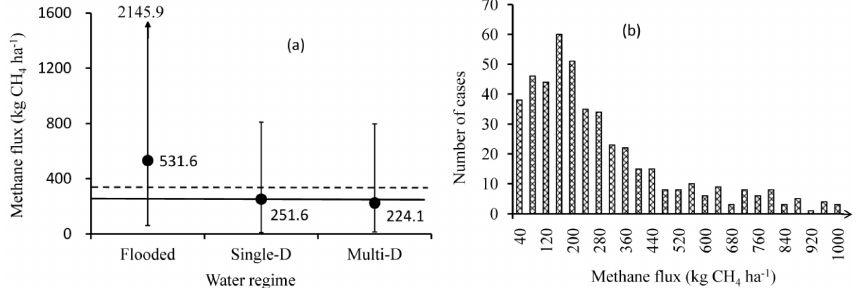
Figure 3. Statistical representations of the measured methane fluxes. (a) Statistical parameters and (b) histogram of the measurements. The solid circles represent the sample mean, and the vertical bars are the 95% confidence intervals of the samples, from the 2.5% percentile to the 97.5% percentile. The dashed line indicates the arithmetic average of all measured fluxes ( m c ). The solid line is the area-weighted mean of the methane fluxes ( m w ) , in reference to the areal proportion of each water regime in the national total rice harvesting area: 10% continuous flooding (Flooded), 20% single drainage (Single-D), and 70% multi-drainage (Multi-D) (Xiong et al., 1992; MWRUC, 1996; Li, 2001; Zou et al.,